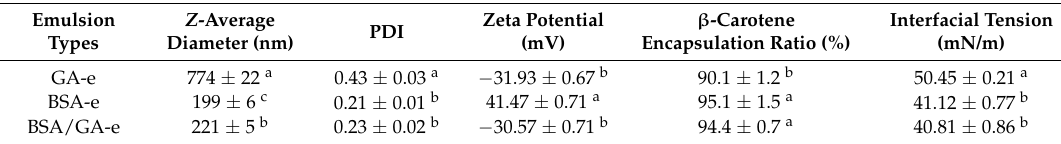
Table 1. The characteristic parameters of the three emulsions